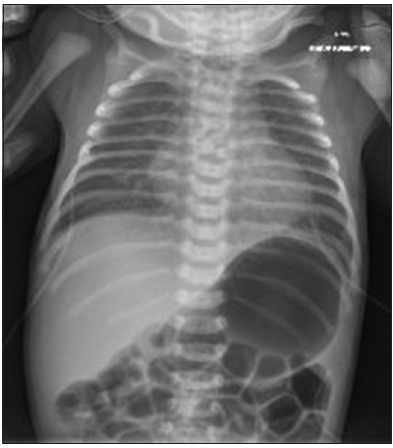
Figure 1: Abdominal X-ray demonstrating nasogastric tube curled in esophagus and stomach distended with air